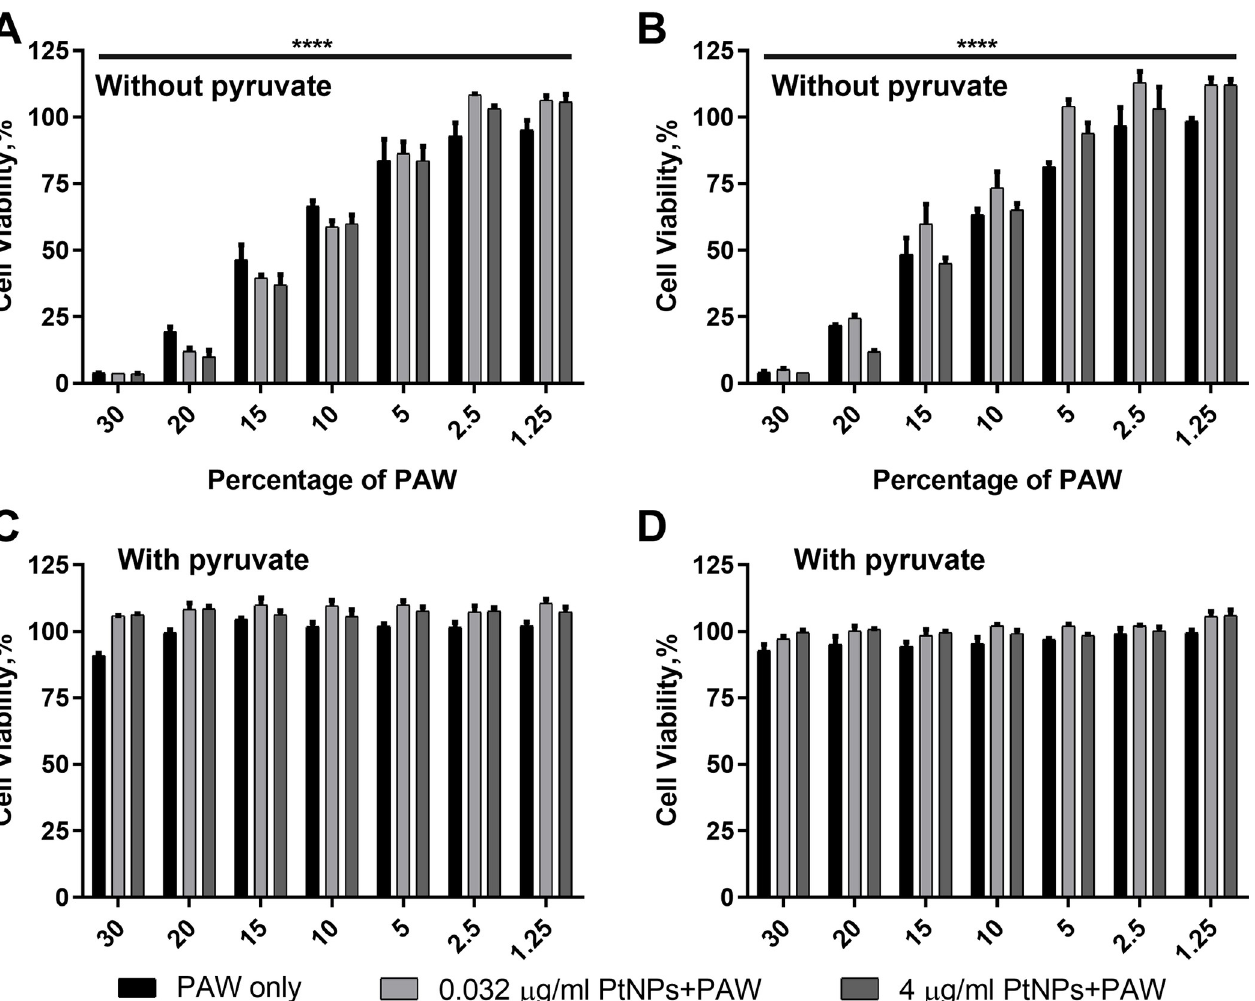
Fig 3. Dose responses for PAW treatment. In medium without Pyruvate, U-251 MG cells were incubated with 0.032 and 4 μ g/ml PtNPs for 24 h (A) or 48h (B) and then treated with increasing concentrations (0 � 30%) of PAW and incubated for 48 h; In medium with Pyruvate, U-251 MG cells were incubated with 0.032 and 4 μ g/ml PtNPs for 24 h (C) or 48h (D) and then treated with increasing concentrations (0 � 30%) of PAW and incubated for 48 h. Alamar blue cell viability assay was carried out 48 h after PAW